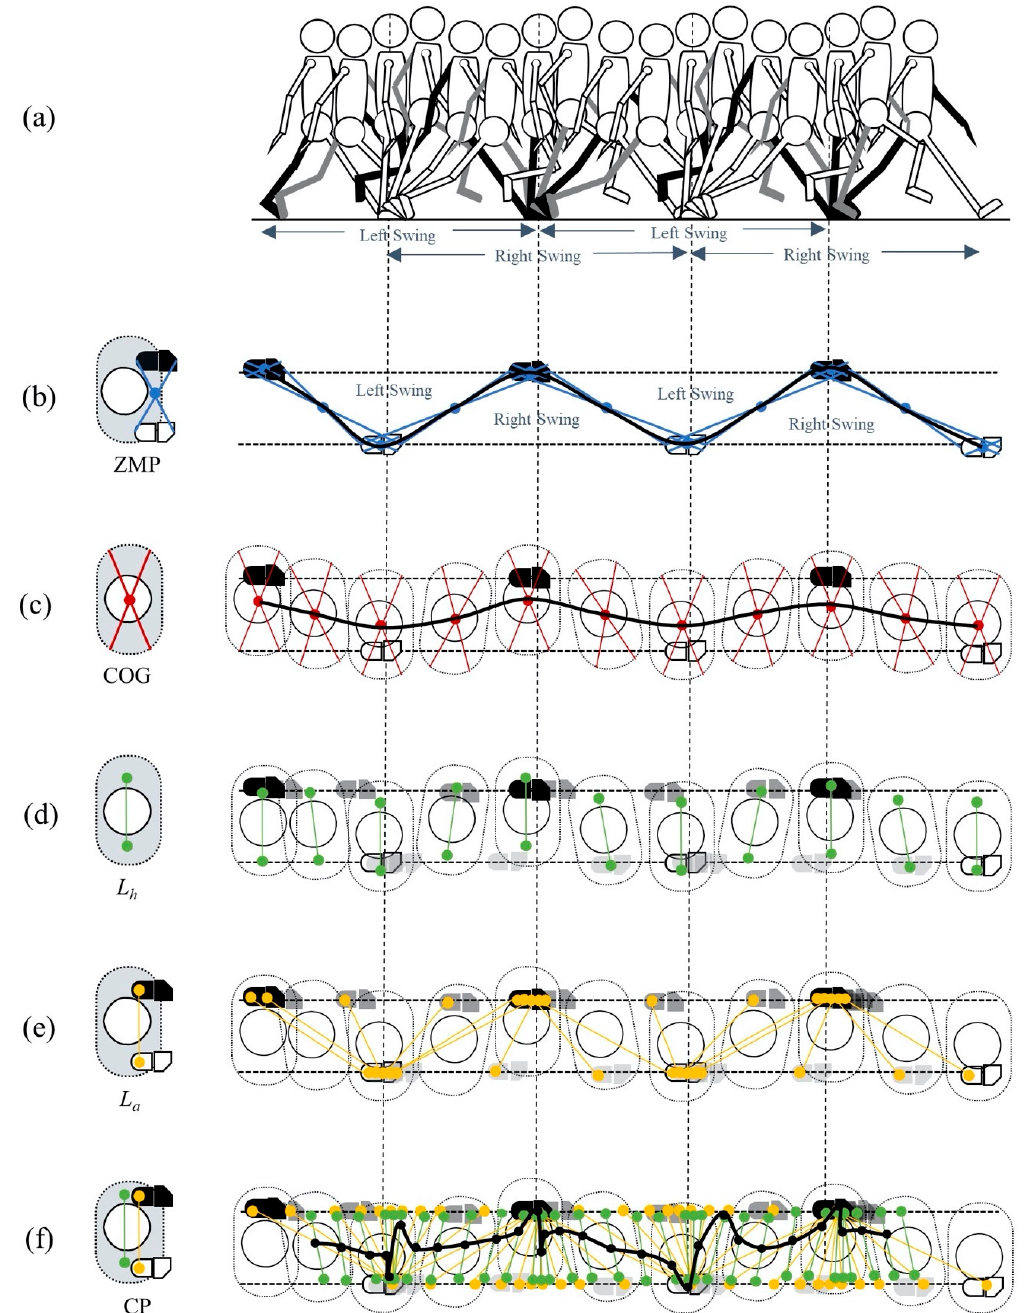
Figure 3. Stability indices and proposed CP in human dynamic motion (total of two cycles): ( a ) Human walking in sagittal plane; ( b ) expected ZMP trajectory in human walking; ( c ) expected COG trajectory; ( d ) line linked on hip joints; ( e ) line linked on ankle joints; ( f ) estimated CP trajectory by L h and L a .